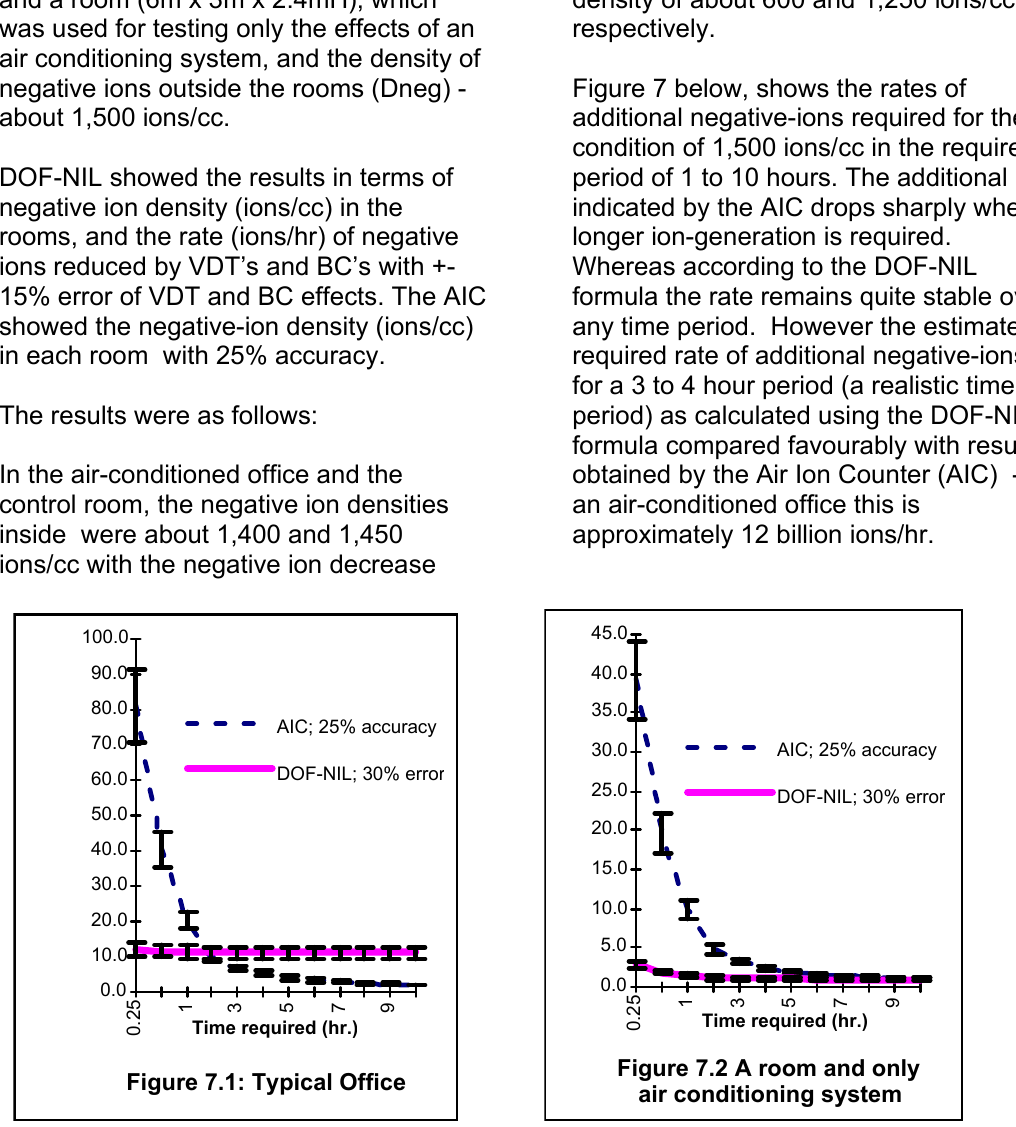
Figure 7.1: Typical Office